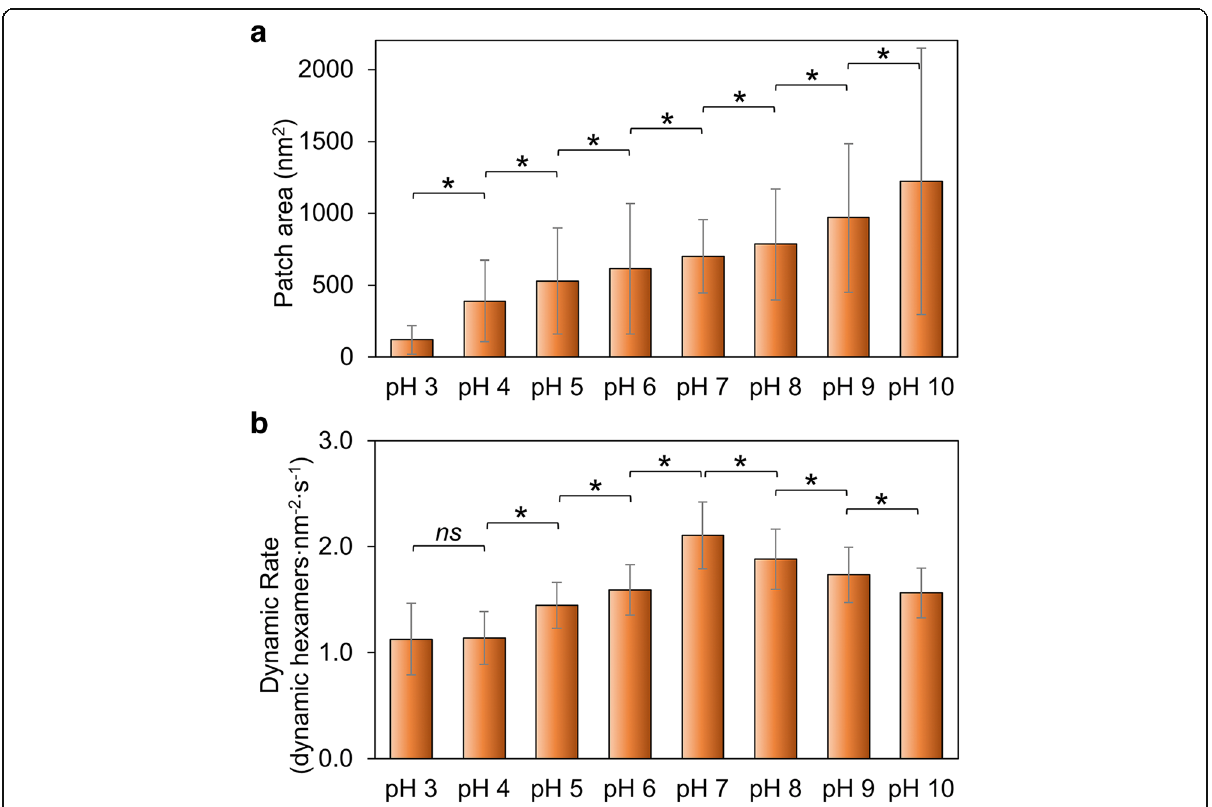
Fig. 2 Effects of environmental pH on the self-assembly of Hoch_5815. a The mean surface areas of individual patches of Hoch_5815 determined by AFM ( n = 50) (Additional file 1: Figure S2). b The mean rates of dynamic events determined by HS-AFM ( n = 50). * p < 0.05, ns not significant (multivariate